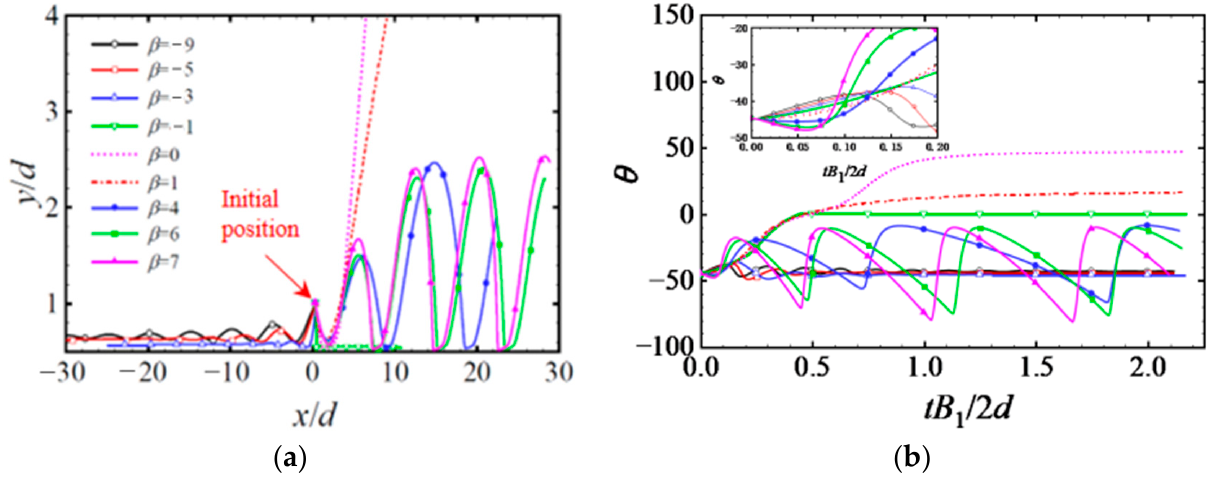
Figure 3. Variations in the ( a ) trajectory and ( b ) azimuth of rod-shaped squirmers with time at different values of β ( Re s = 0.1, s = d , i = 2).